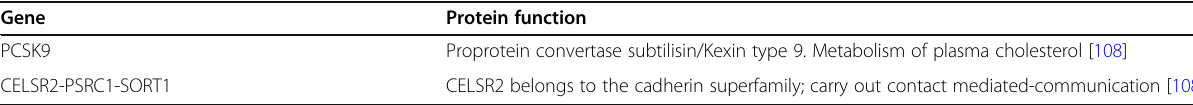
Table 6 Genes whose variants decrease the risk of DM and CVD Gene Protein function